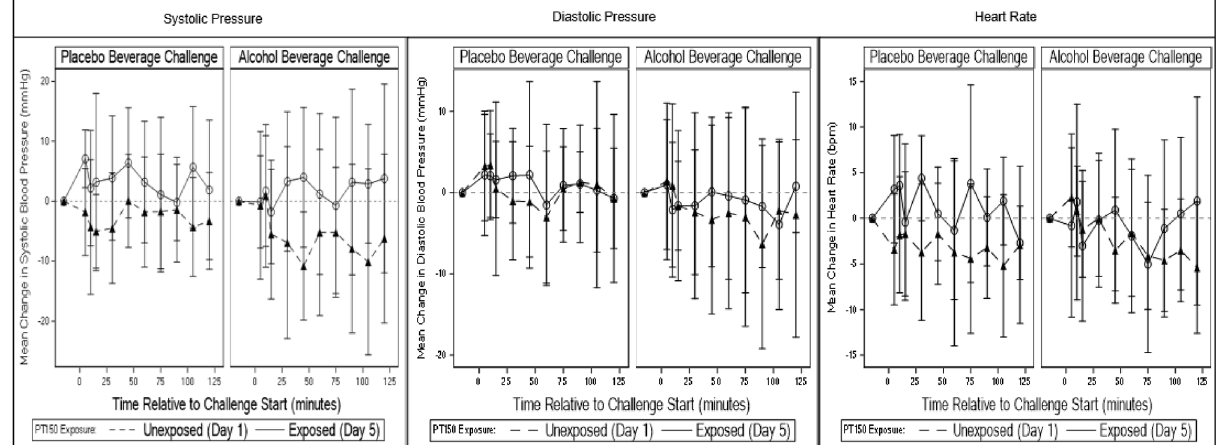
Figure 3. PT150 effects on physiological outcome measures; mean changes relative to the pre-challenge collection over the course of the placebo and alcohol challenges. Error bar represents ± 1 SD. Time 0 is the start of the challenge. The triangle symbol and dotted line represent Day 1 while the circle symbol and solid line represent Day